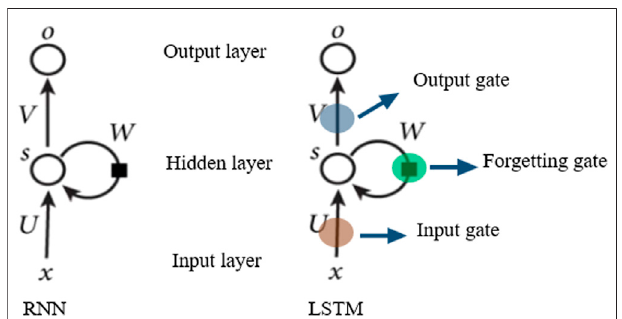
FIGURE 1 | Structure of RNN and